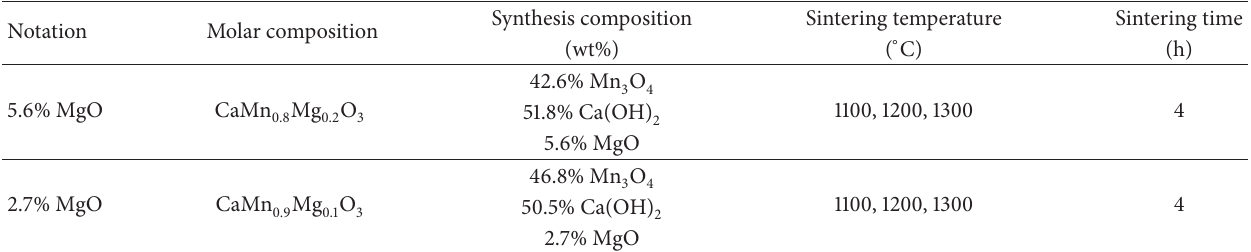
Table 1: Composition of Ca-Mn-Mg oxygen